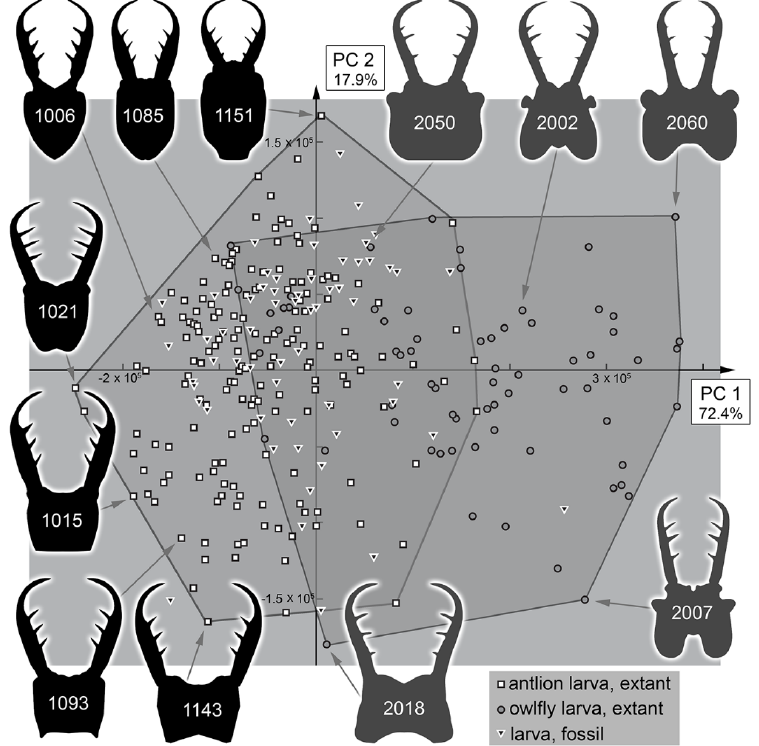
Figure 37. Scatterplot of PC2 vs. PC1 values of head shapes of all specimens. Black heads = antlion larvae; grey heads = owlfly larvae.